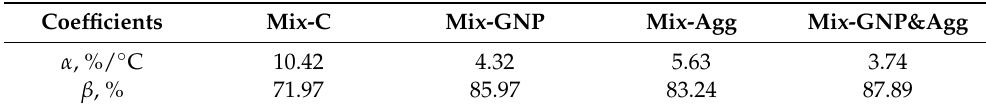
Table 2. Coefficients of the linear model between T and φ 30